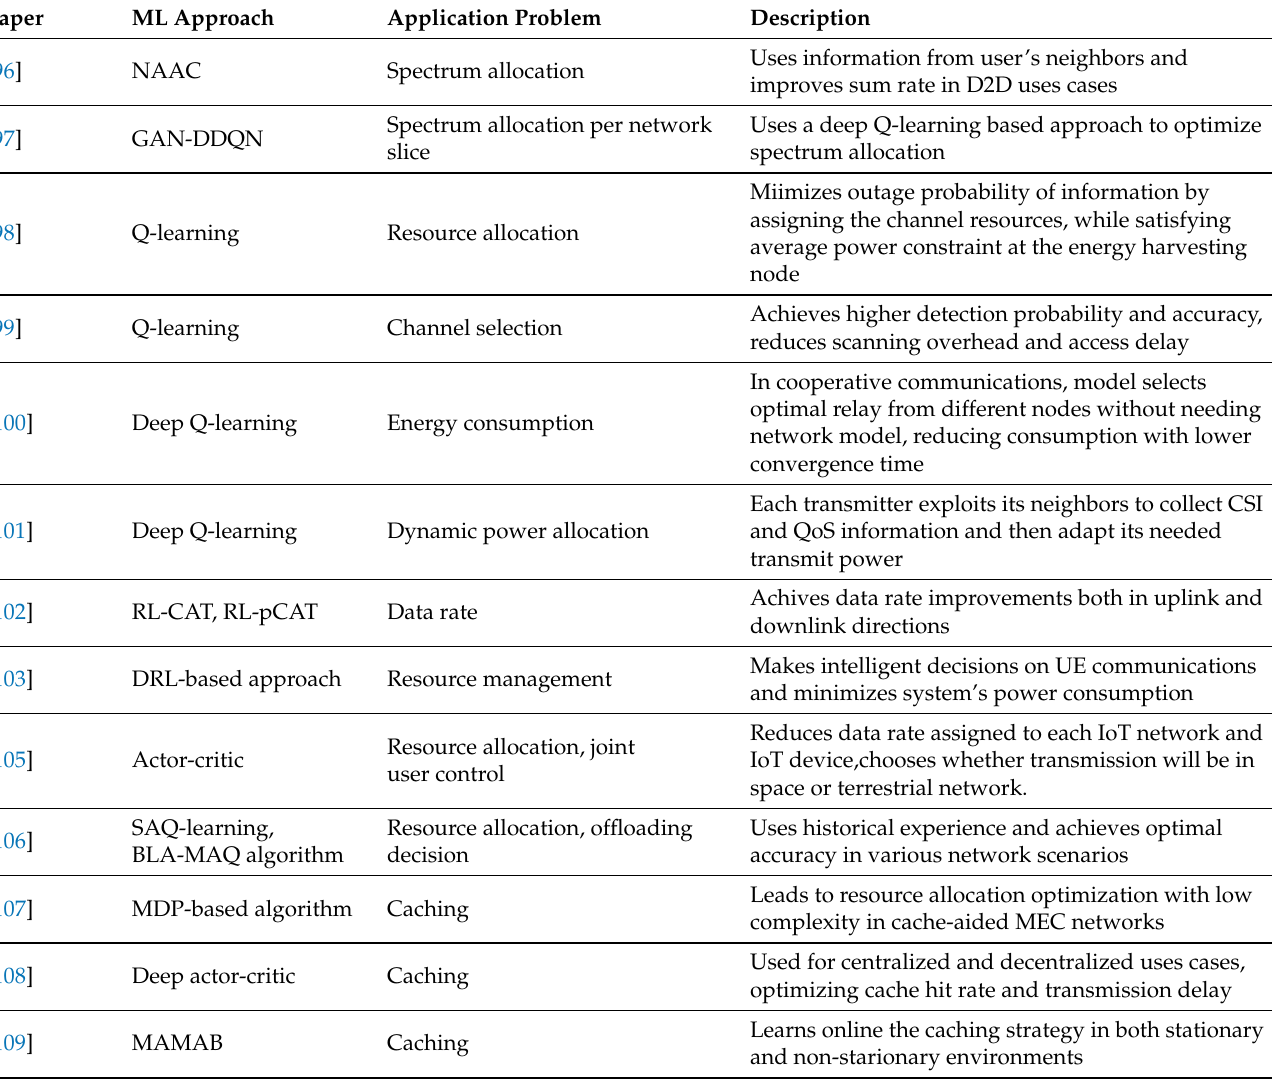
Table 8. RL models in 6G optimization and caching